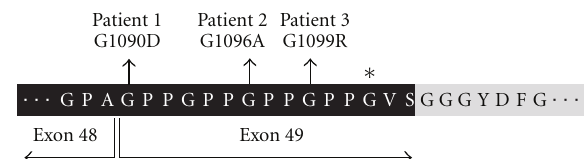
Figure 8: Amino acid sequence of collagen α 2 (I) between residues 1087 and 1111. Residues that are part of the triple-helical domain are shown on black background. The first residues of the C- telopeptide are shown in italics and on gray background. The asterisk indicates the glycine residue that is a ff ected in a boy with OI type IV who has normal height and a normal appearance of hands and feet, adapted from